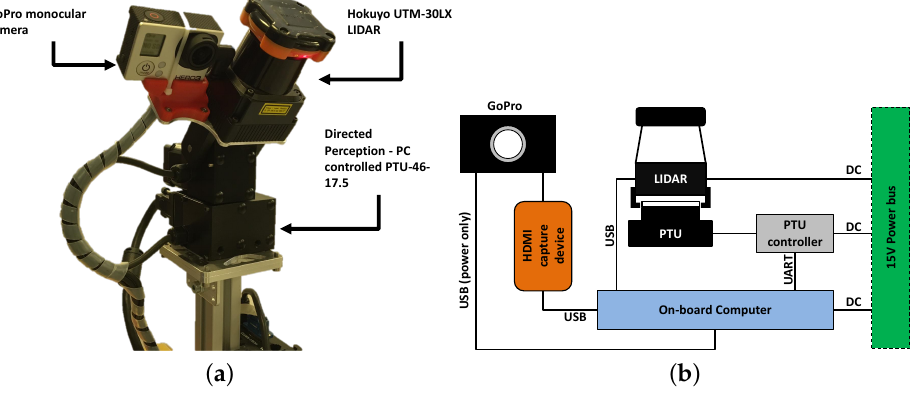
Figure 6. Proposed hardware setup for fusion of camera and LIDAR data for planetary scene reconstruction ( a ); and device connections ( b